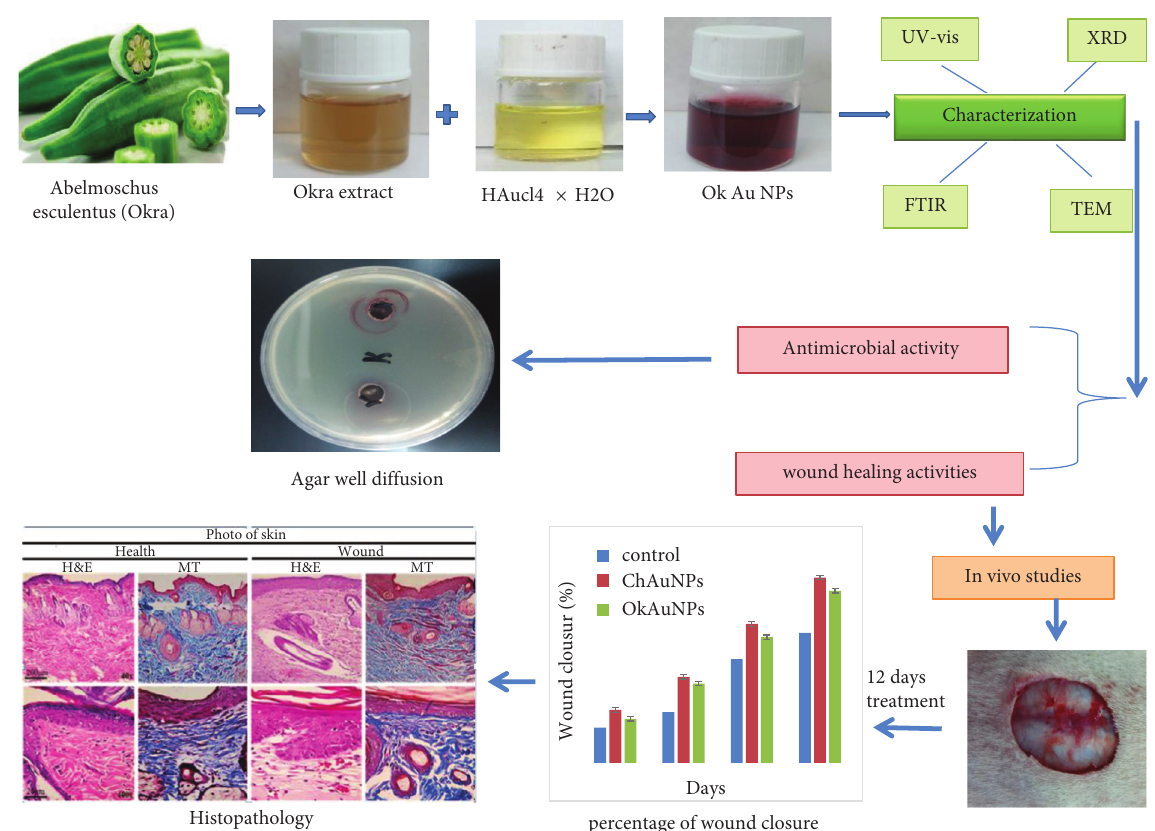
Figure 1: Graphical abstract of green/chemical synthesis of Au